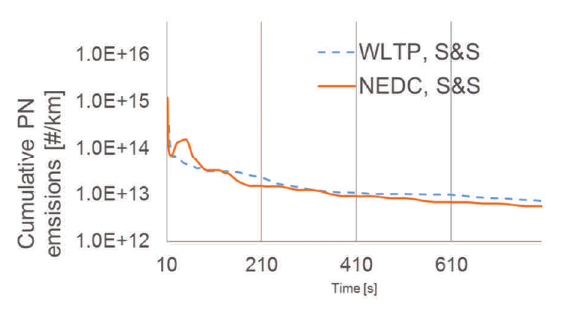
Fig. 4. Distance-specific cumulative PN emissions (solid particles only) from vehicle 1, calculated according to (2). The first 10 seconds have been